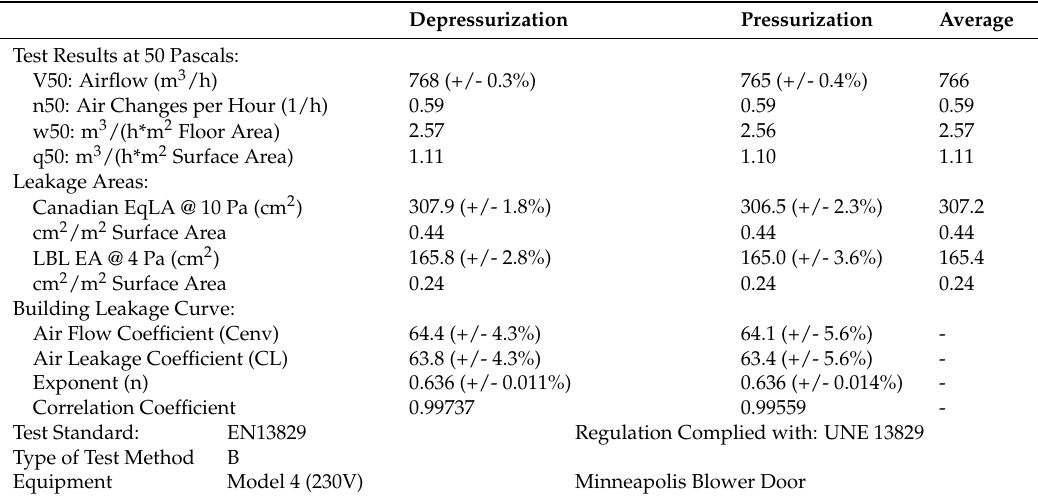
Figure 19. Air volume at different pressures in the blower door test (BDT). Table 3. Summary of BDT